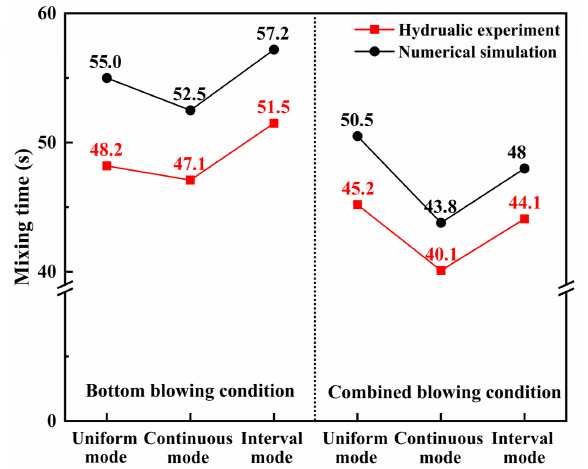
Figure 9. Effect of bottom blowing mode on the mixing time under different blowing